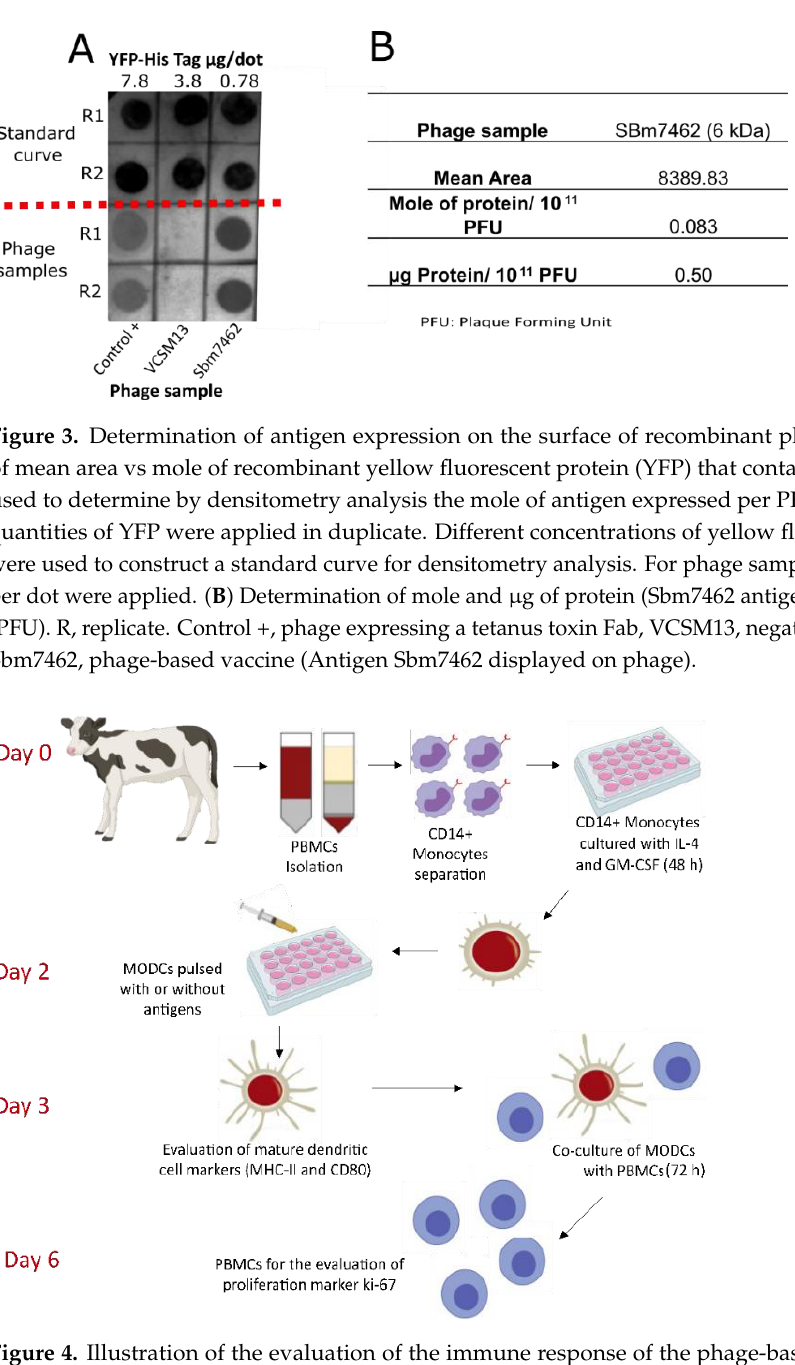
Figure 4. Illustration of the evaluation of the immune response of the phage-based vaccine using the bovine MODC-based assay. On day 0, CD14+ monocytes were isolated from PBMCs. Purified CD14+ monocytes were cultured in the presence of bovine IL-4 and GM-CSF. On day 2, cultured monocytes were evaluated for the presence of dendritic cell differentiation markers (CD80 and MHC-II). Once the presence of differentiation markers was confirmed, the cells were pulsed with or without the antigens. On day 3, freshly prepared PBMCs from the same animal were co-cultured with the antigen-treated dendritic cells. On day 6, PBMCs were harvested and evaluated for the proliferation of lymphocytes by measuring the expression of the ki-67